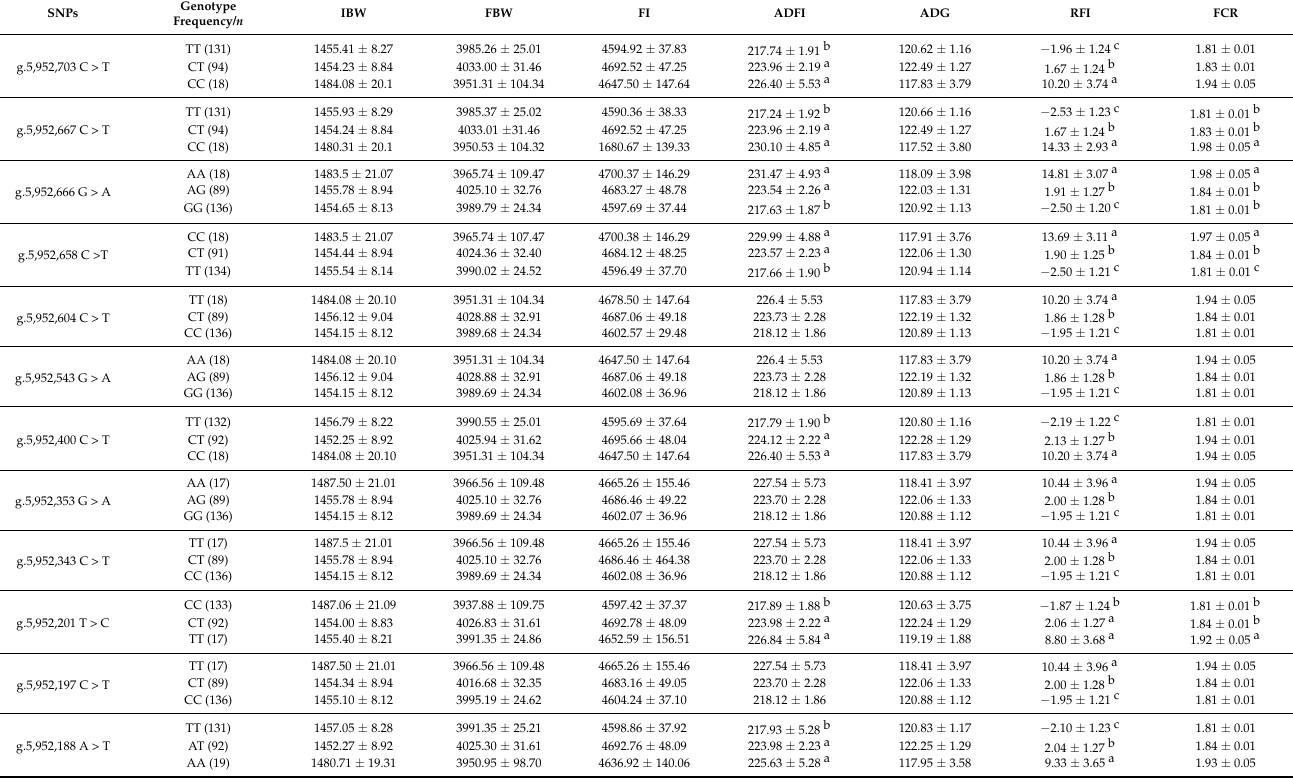
Table 3. Association analysis of RXRA SNPs with feed efficiency traits (mean ±